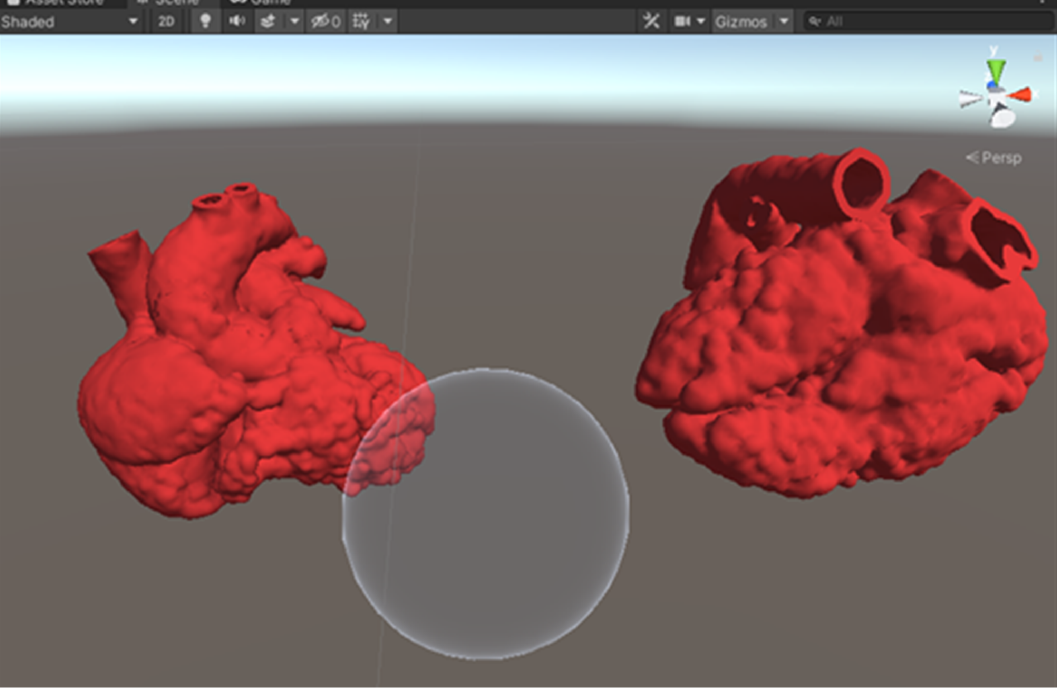
Figure 3. A screenshot of the Unity scene with 2 heart models and a sphere to serve as the clipping tool.